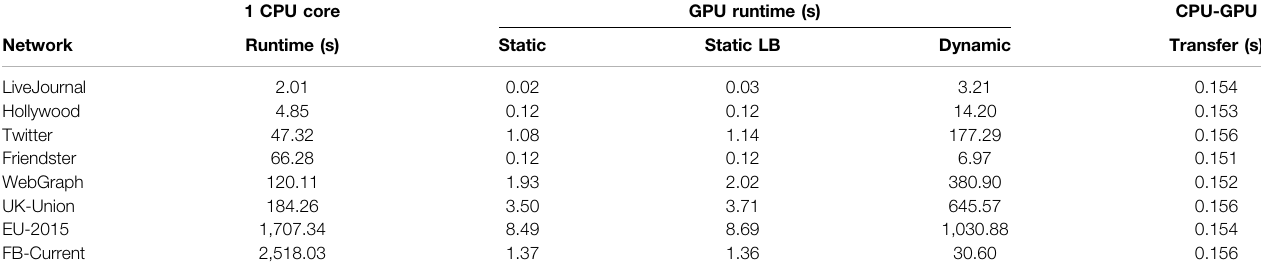
TABLE 3 | Network generation time from coarsened input degree distribution.